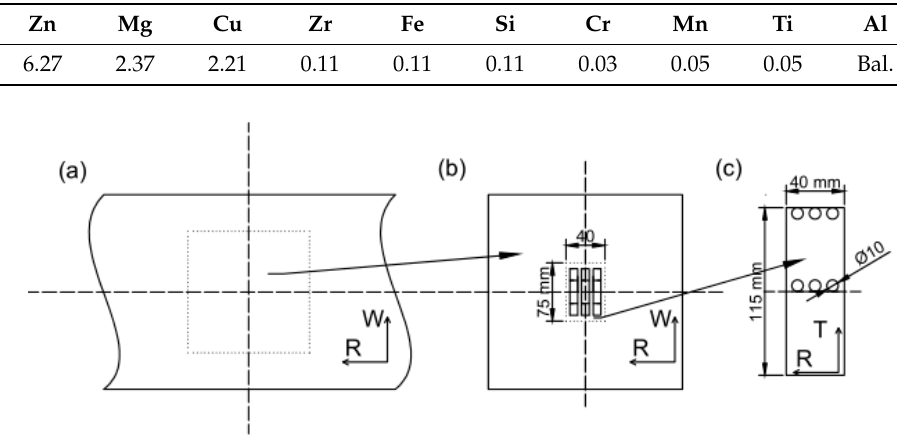
Figure 1. Schematic diagrams of the sampling positions.